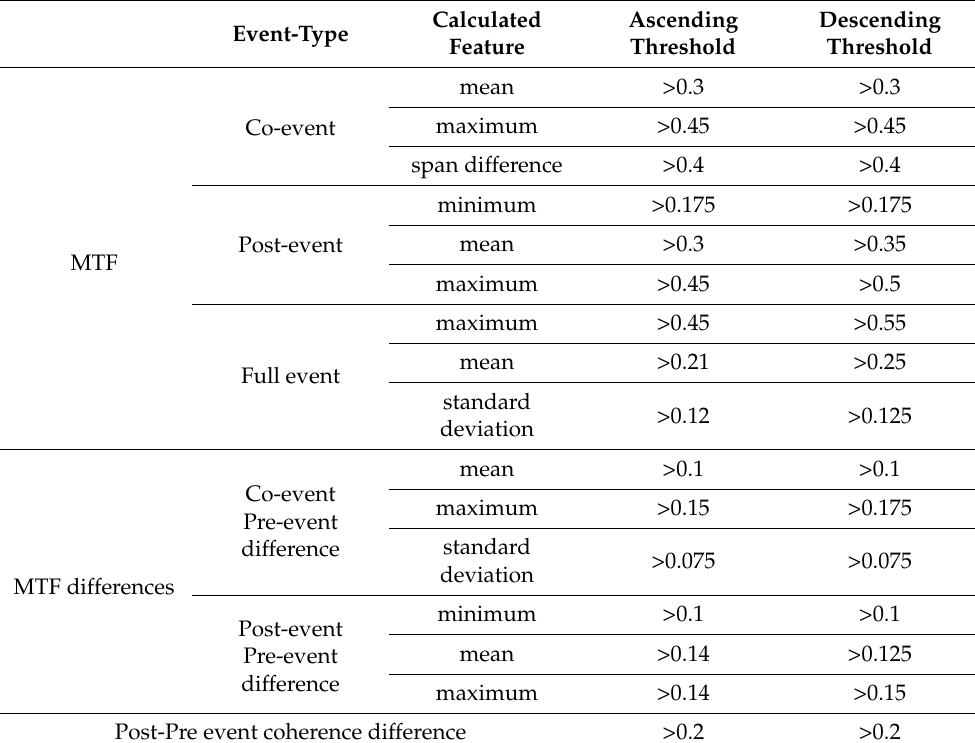
Table 1. Thresholds for multi-temporal coherence features and pre-and post-event coherence differ- ences used during the classification according to event types and